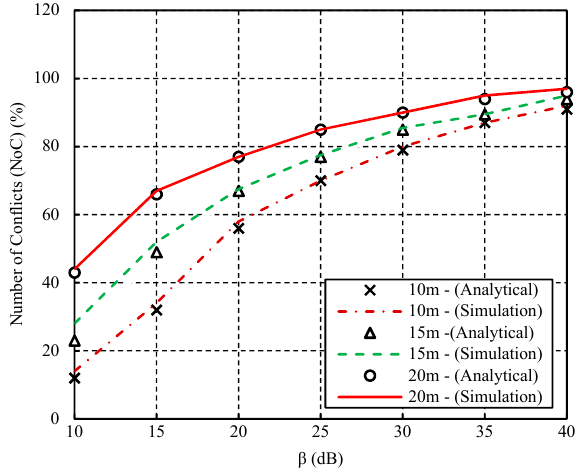
Figure 2. Signal to interference (SIR) threshold impact on number of conflicts Figure 2. S ignal to interference ( SIR) threshold impact on number of conflicts (NoC).